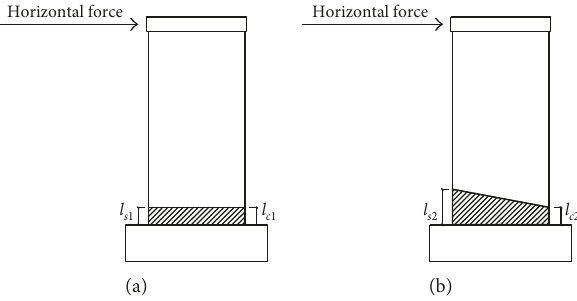
Figure 4: Deformation coordination region of (a) bonded shear wall and (b) unbonded shear wall.